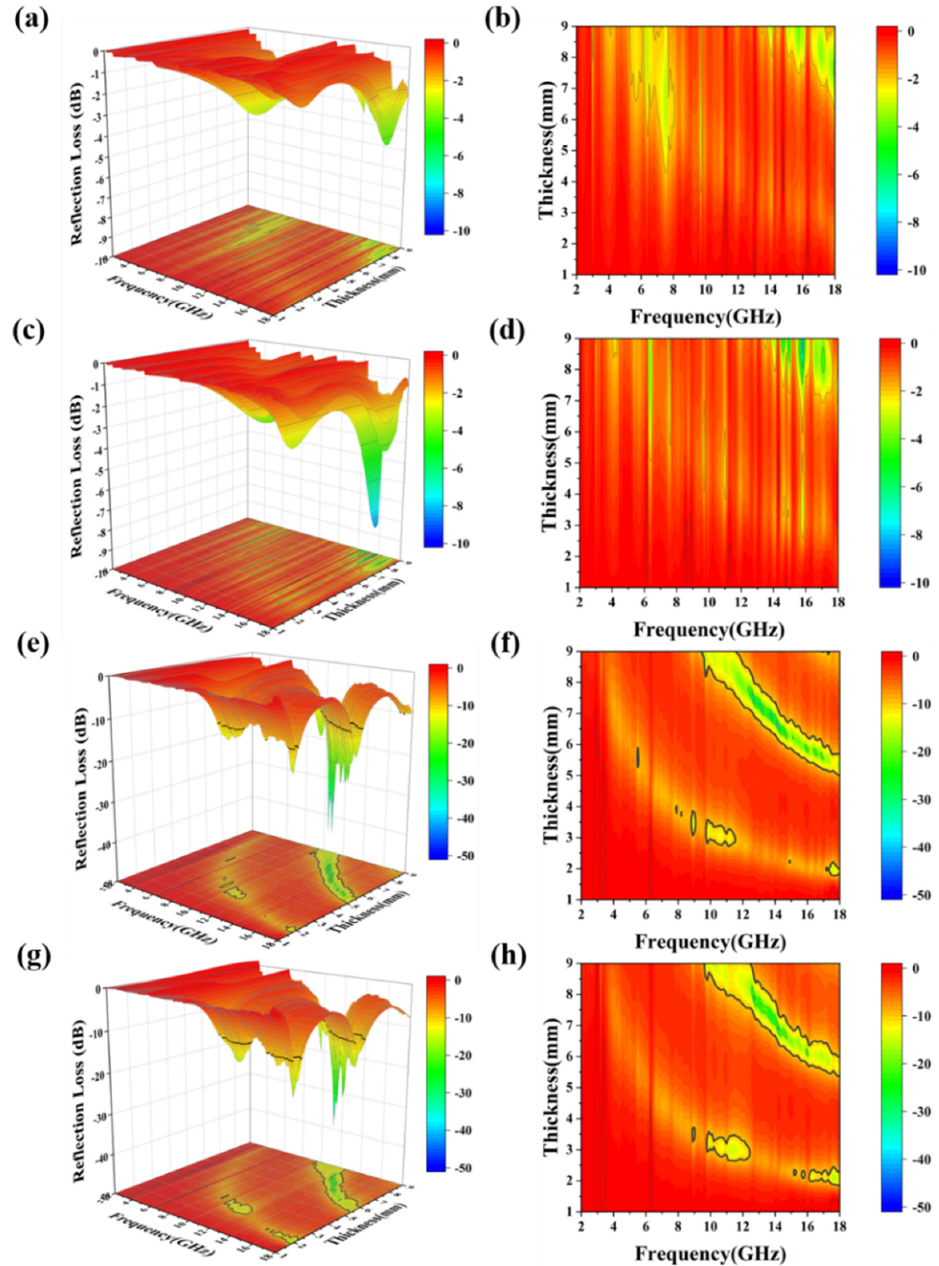
Figure 7. Three-dimensional diagrams and contour diagrams of the RL values of ( a , b ) Co 3 O 4 , ( c , d ) S1, ( e , f ) S2 and ( g , h ) S3.